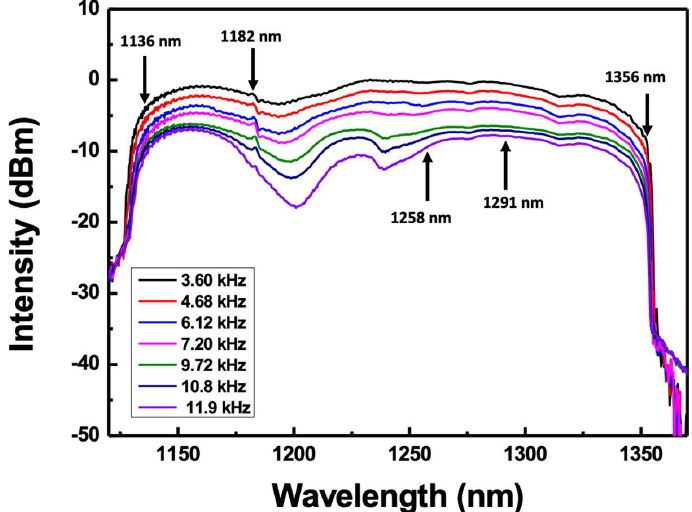
Figure 10. Scanning bandwidth variations of wideband WSL with scanning frequency .